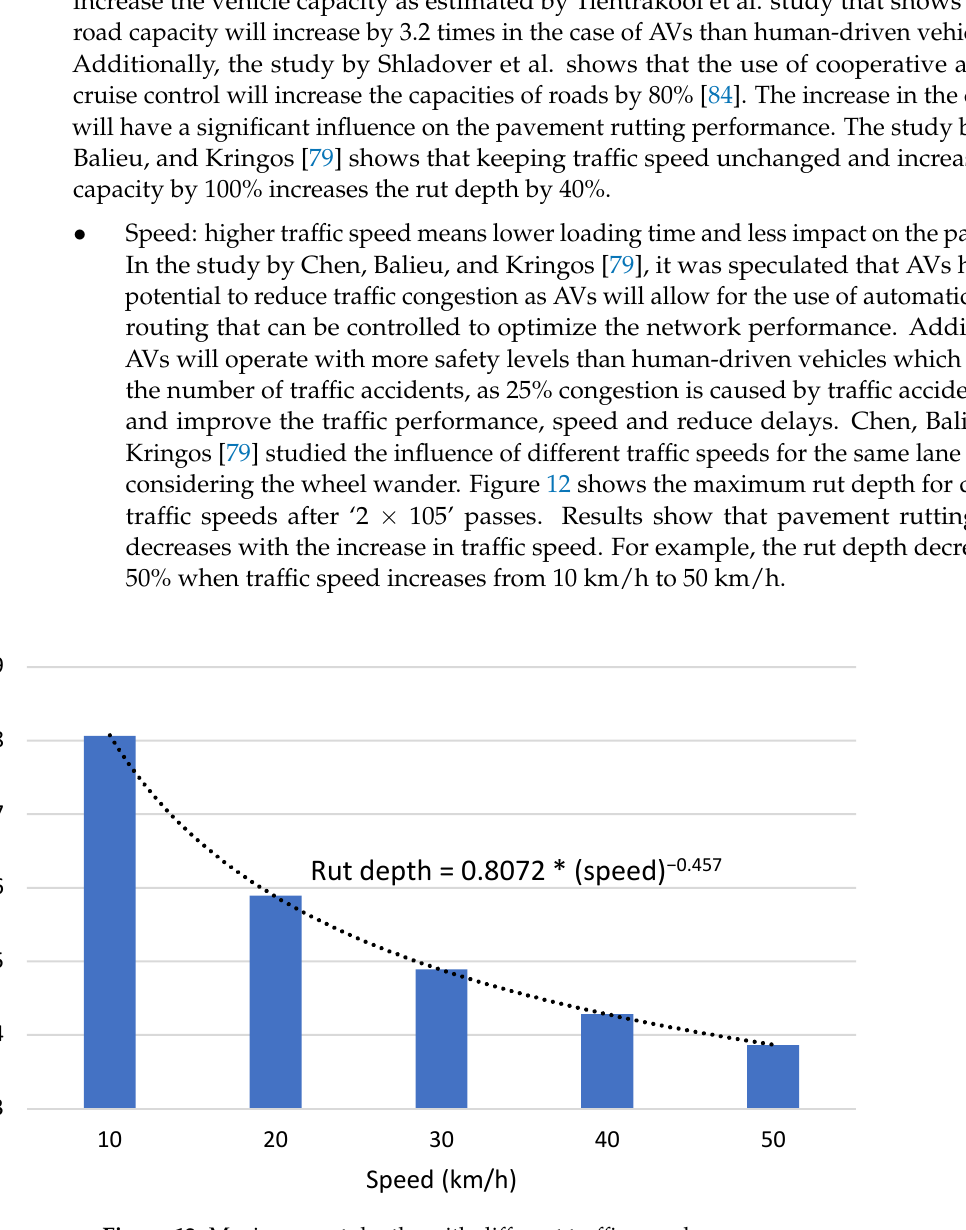
Figure 12. Maximum rut depths with different traffic speed.